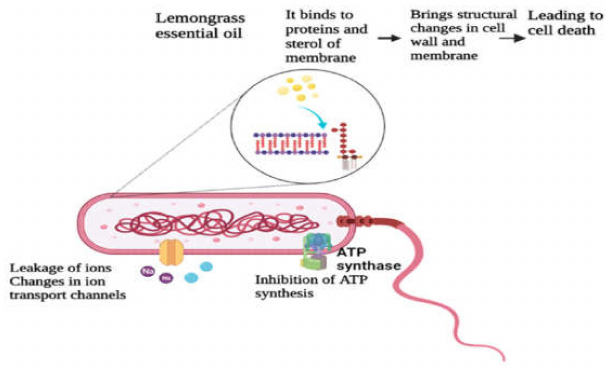
Figure 2. Effect of lemongrass essential oil on the bacterial